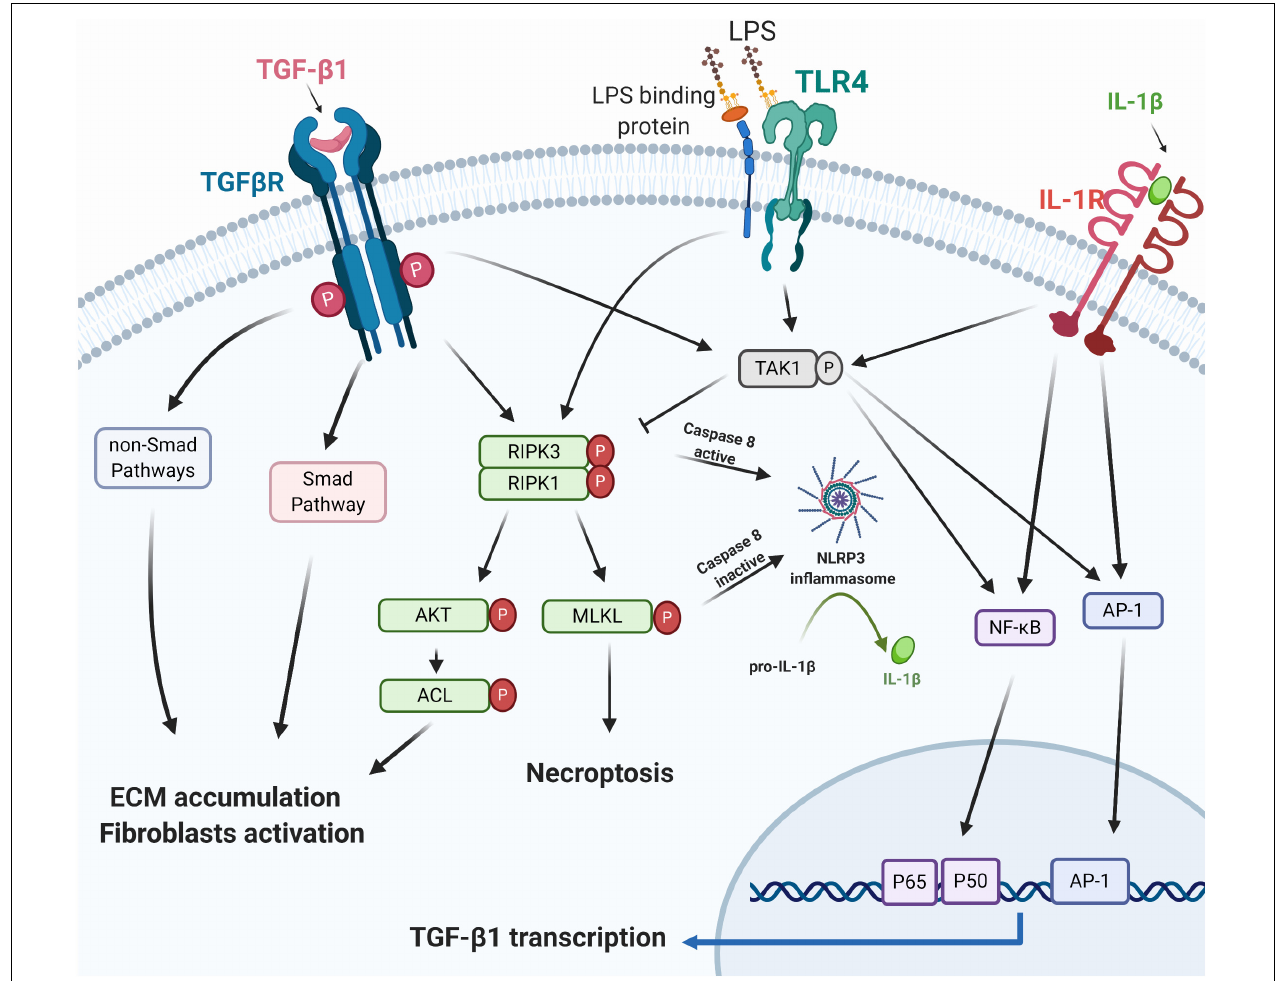
FIGURE 1 | RIPK3 and TGF- β 1. TGF- β 1 exhibits its biological function via the canonical Smad/non-Smad pathways or TAK1/necrosome/AKT/ACL signaling to mediate ECM accumulation and fibroblast activation. Necroptosis or RIPK3 facilitates NLRP3 inflammasome assembly, triggers mature IL-1 β secretion, and promotes the TGF- β 1 transcription via the IL-1 β regulated AP-1 and NF κ B pathway (Lee et al., 2006). IL-1 β , TGF- β , and TLR signaling pathways all activate TAK1 and its regulated inflammatory mediators (Kim and Choi, 2012; Fechtner et al., 2017). RIPK3, Receptor-interacting serine/threonine-protein kinase 3; TGF- β 1, transforming growth factor beta-1; TAK1, TGF- β -activated kinase 1; AKT, protein kinase B; ACL, ATP citrate lyase; ECM, extracellular matrix; TLR4, toll-like receptor 4; LPS, lipopolysaccharides; NLRP3, NOD-, LRR- and pyrin domain-containing protein 3; IL-1 β , interleukin-1 β ; AP-1, activator protein 1; NF κ B, nuclear factor-kappa B. Created with